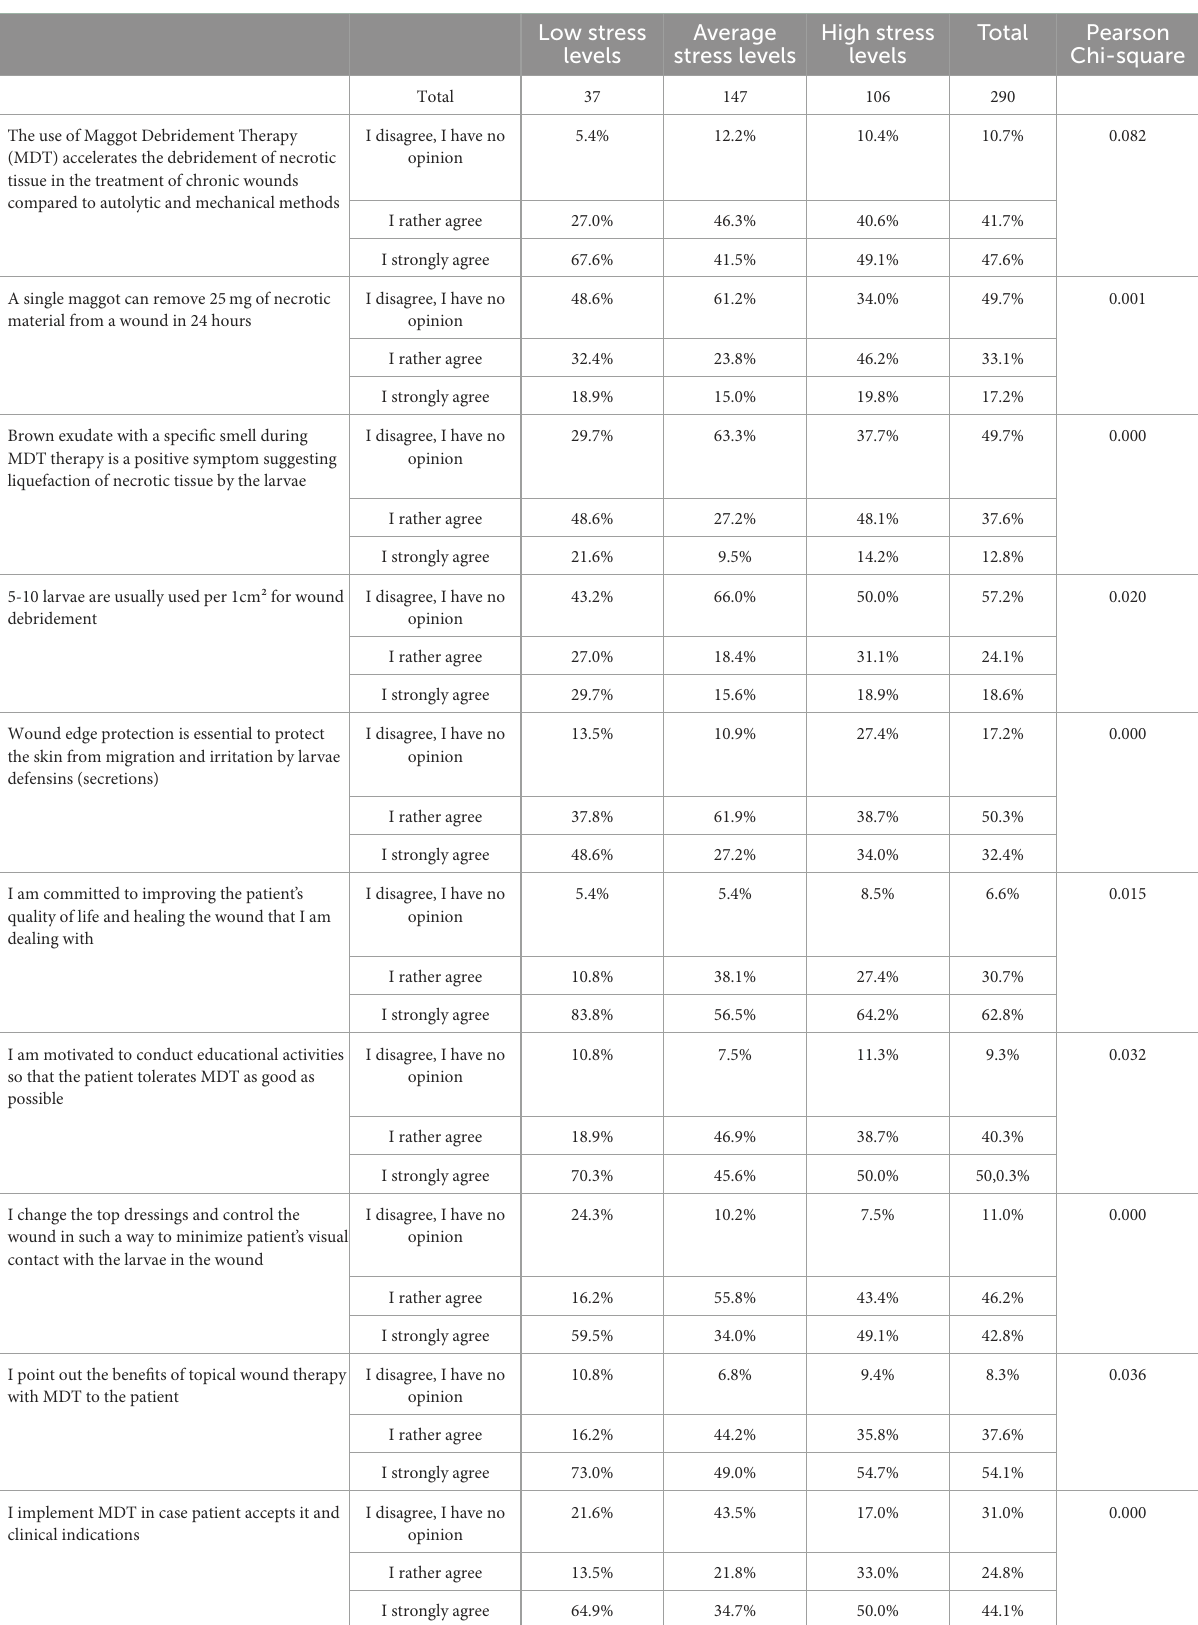
TABLE 6 Readiness to implement MDT therapy (MDT 10 scale) and the level of stress intensity.